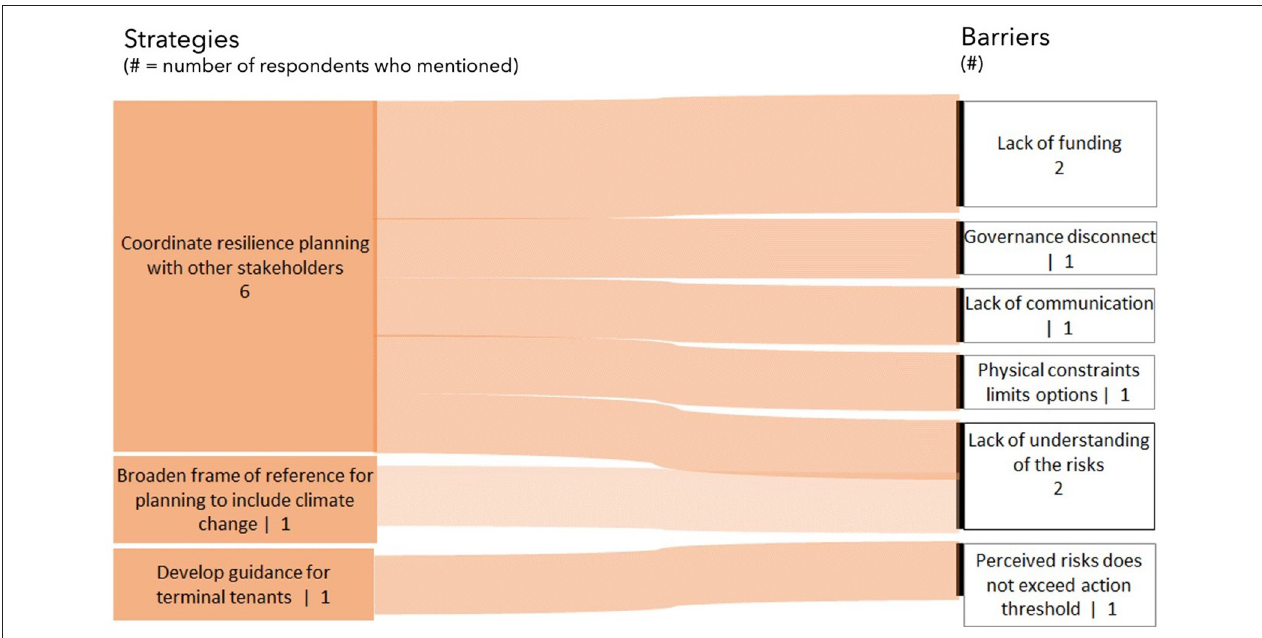
FIGURE 4 | Better planning and guidance strategies (left side) to overcome identified barriers (right